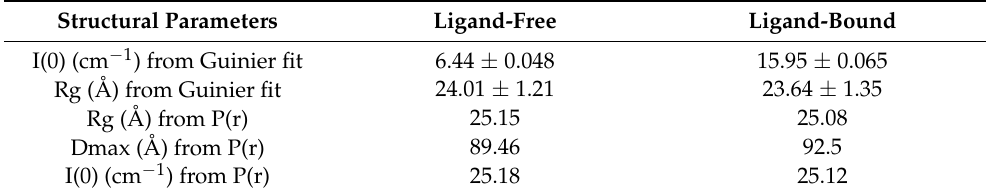
Table 1. Radius of gyration (Rg) and maximum dimension (Dmax) for the THF-II riboswitch in different solution conditions, measured by